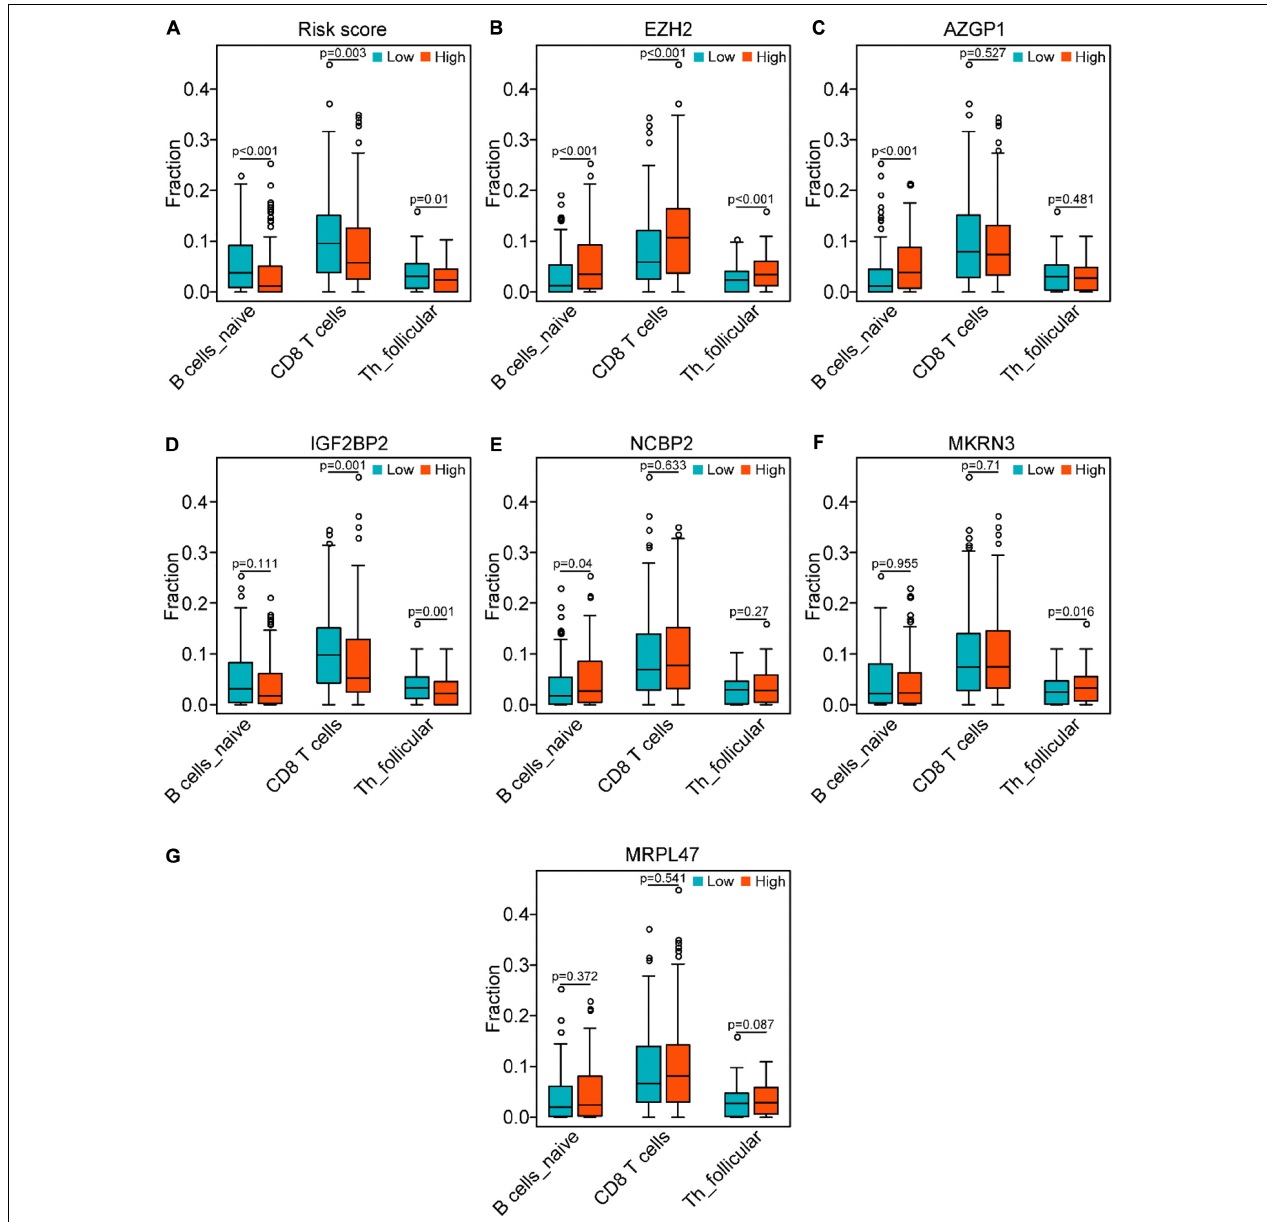
FIGURE 10 | Correlation of the genes of the risk model with the three immune cells in the TCGA data set. (A) Comparison of the three immune cells (naïve B cells, CD8 T cells, and follicular helper T cells) between the high-risk and low-risk groups. (B–G) Distribution of the three immune cells in the subgroups with high or low expression of EZH2, AZGP1, IGF2BP2, NCBP2, MKRN3, and MRPL47,